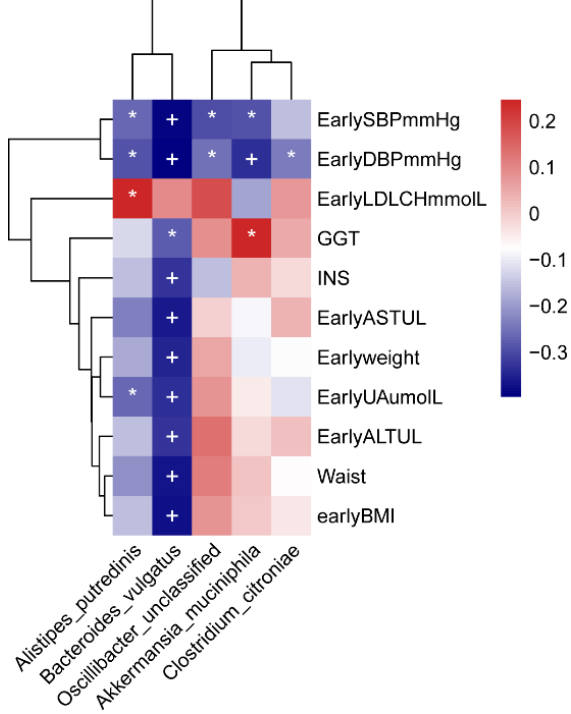
Figure 5. Heatmap of Spearman correlation between different species and clinical indices between case and control groups. Positive correlations are indicated in red text and negative correlations are indicated in blue text. (* p < 0.05; + p < 0.01). SBP, systolic blood pressure; DBP, diastolic blood pres-